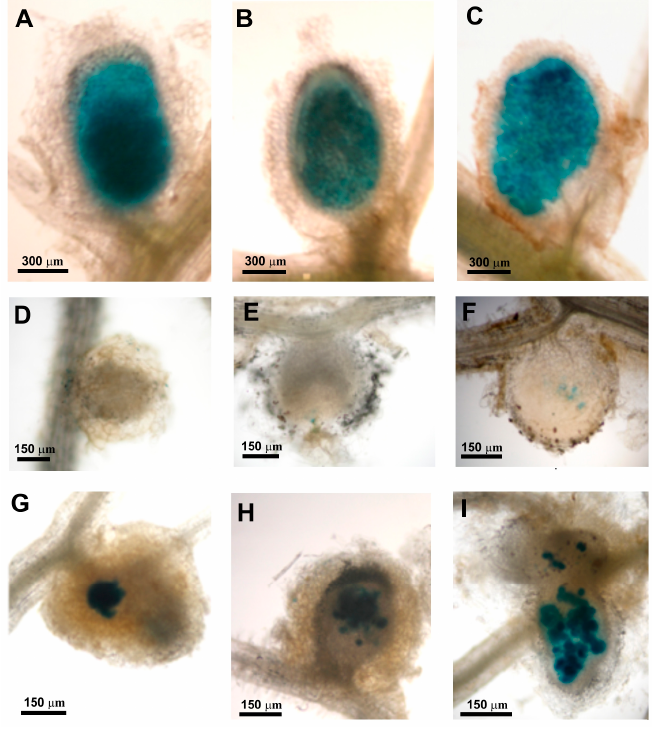
Figure 12. Light microscopy of clover ( Trifolium pratense ) root nodules elicited by the wild-type strain R. leguminosarum Rt24.2 and several derivatives harboring gusA reporter gene encoding β -glucuronidase. The images show 21-dpi nodules occupied by Rt24.2 ( A ), Rt297(pPL1) ( B ), and Rt24.2(pPL1) ( C ). ( D – I ) Nodules formed after inoculation with Rt297: ( D – F ) 7–dpi nodules; ( G , H ) 14-dpi nodules; and ( I ) a 21-dpi nodule.